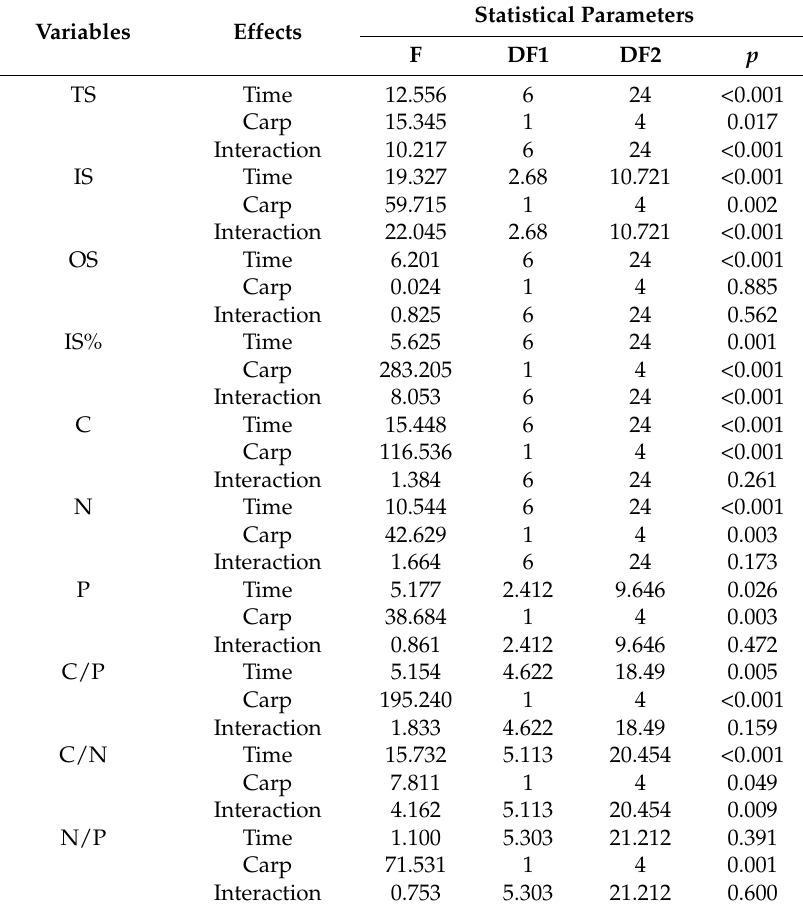
Table 2. Detailed information on rmANOVA results on the effects of crucian carp (Carp) on total (TS), inorganic (IS) and organic (OS) solids, and carbon (C), nitrogen (N) and phosphorus (P) composition during the experiment